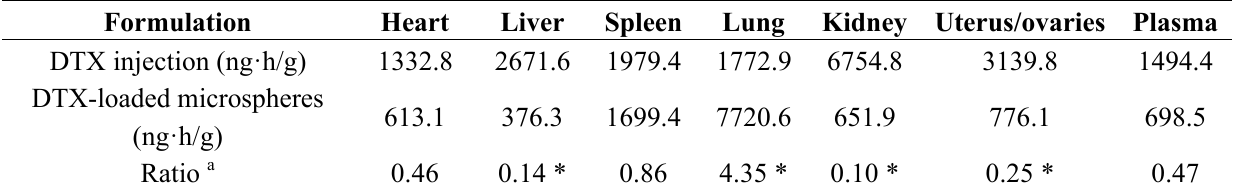
Table 3. The AUC of DTX in plasma and tissues after i.v. administration of injection 0–24 h and microspheres to mice ( n =